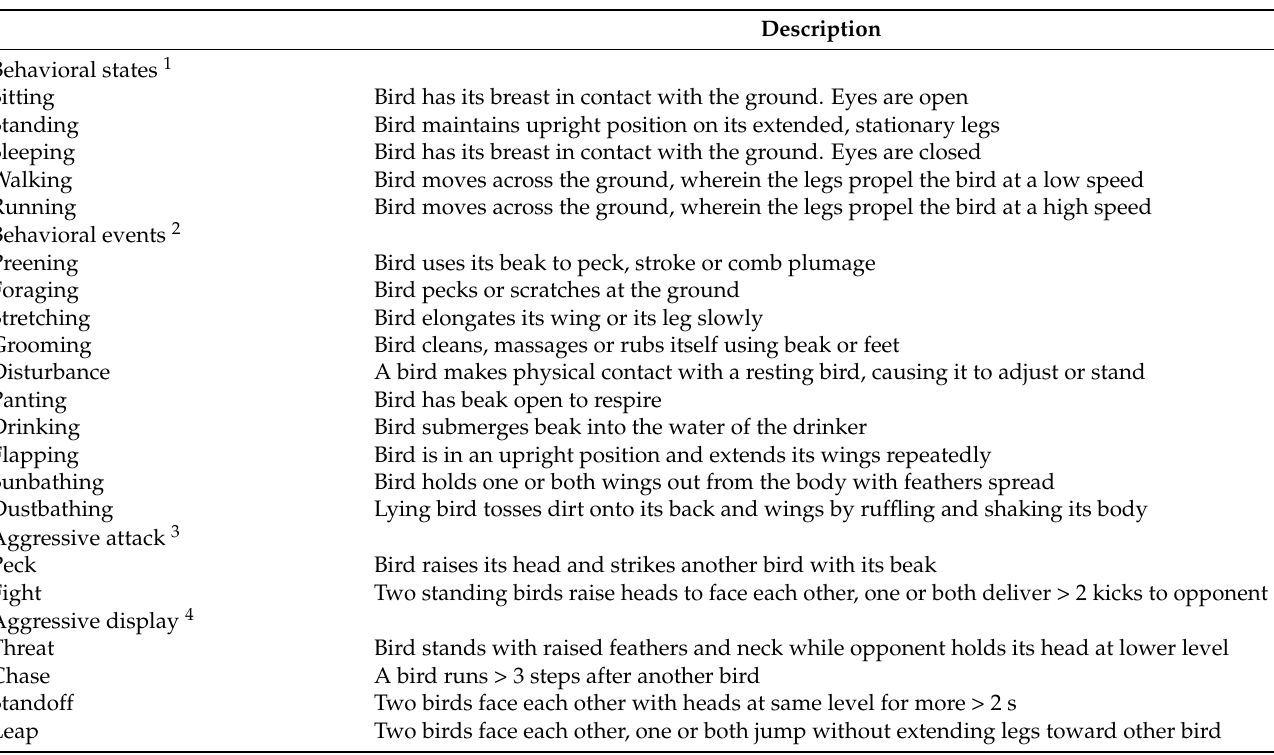
Table 1. Ethogram for behaviors of mixed-sex Freedom Ranger chickens raised in a free-range system from 5 to 11 weeks of age observed in the range and shelter. Behaviors and descriptions are modified from Ventura et al. [10], Mollenhorst et al. [11] and Santos et al.